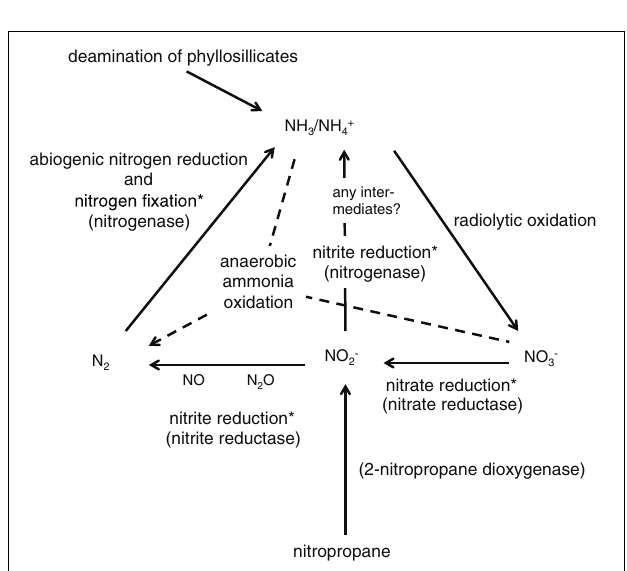
FIGURE 7 | Schematic diagram of the proposed N cycle in deep terrestrial subsurface sites in South Africa. Solid lines indicate processes suggested by molecular (this study) and geochemistry analyses (Silver et al., 2012). Dashed lines indicate processes that are known in the global N cycle but their occurrence in deep terrestrial subsurface sites is yet to be proven. Asterisks denote microbially mediated